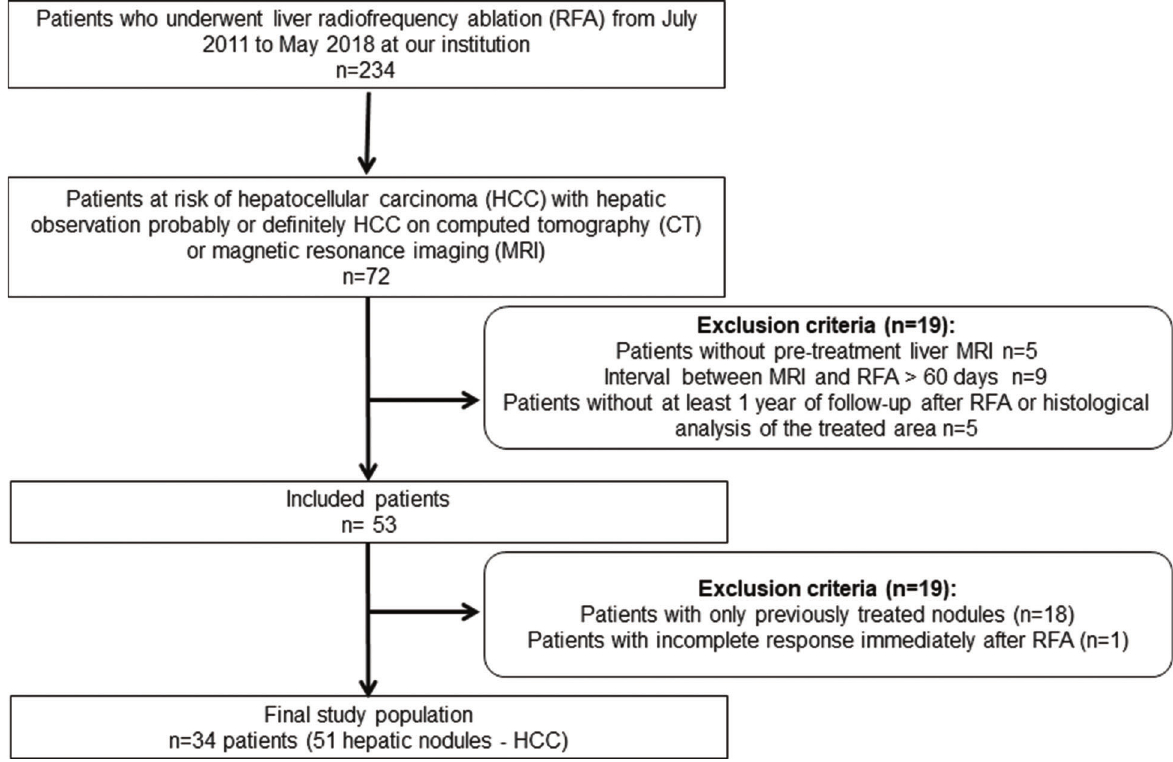
Figure 1 - Flowchart summarizing the inclusion and exclusion